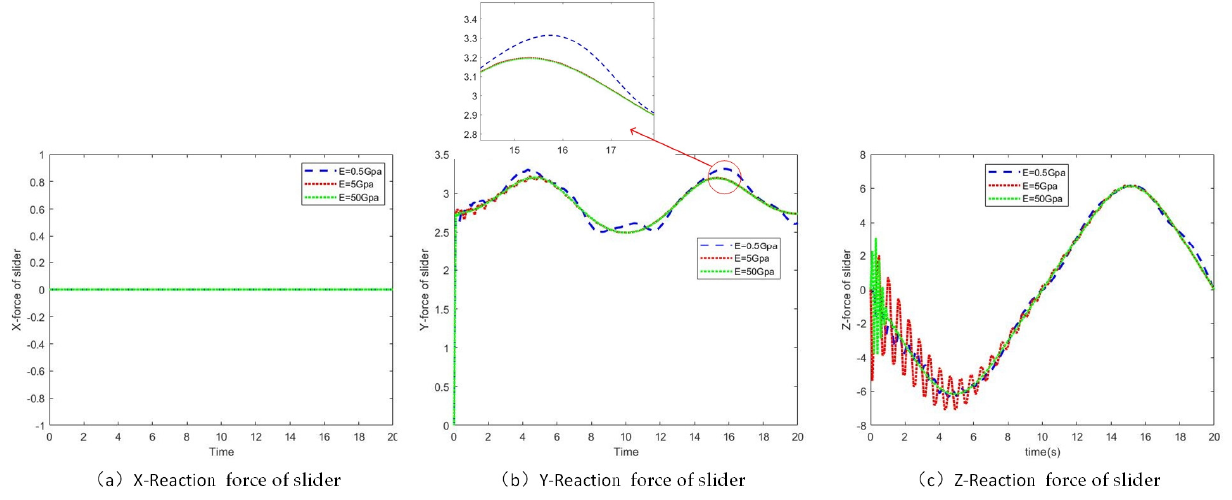
Figure 12. Reaction force of slider rotating joint with different elastic modulus.